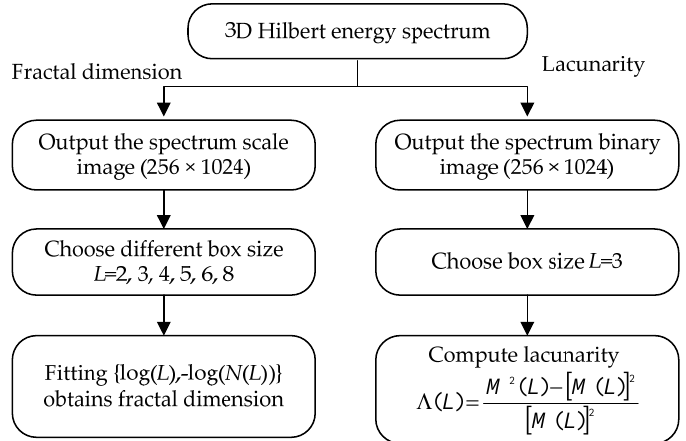
Figure 6. Procedure for computing fractal dimension and lacunarity.